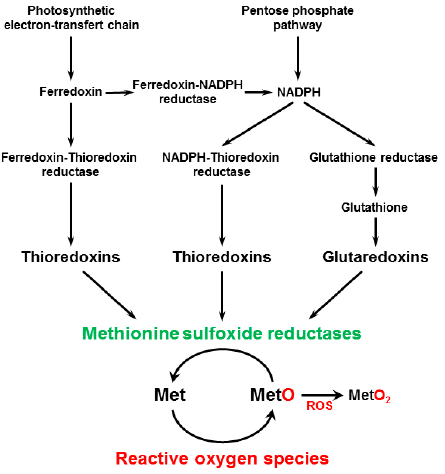
Figure 1. Reducing pathways of plant methionine sulfoxide reductases (MSRs). Methionine (Met) can